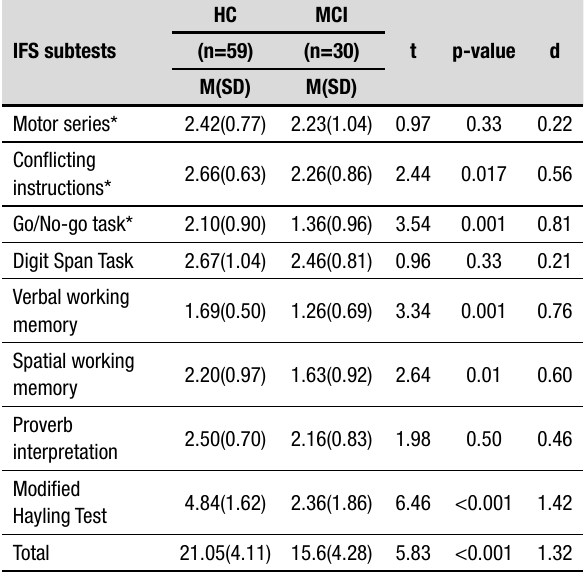
Table 3. Performance of healthy controls and mild cognitive impairment patients in the INECO Frontal Screening.